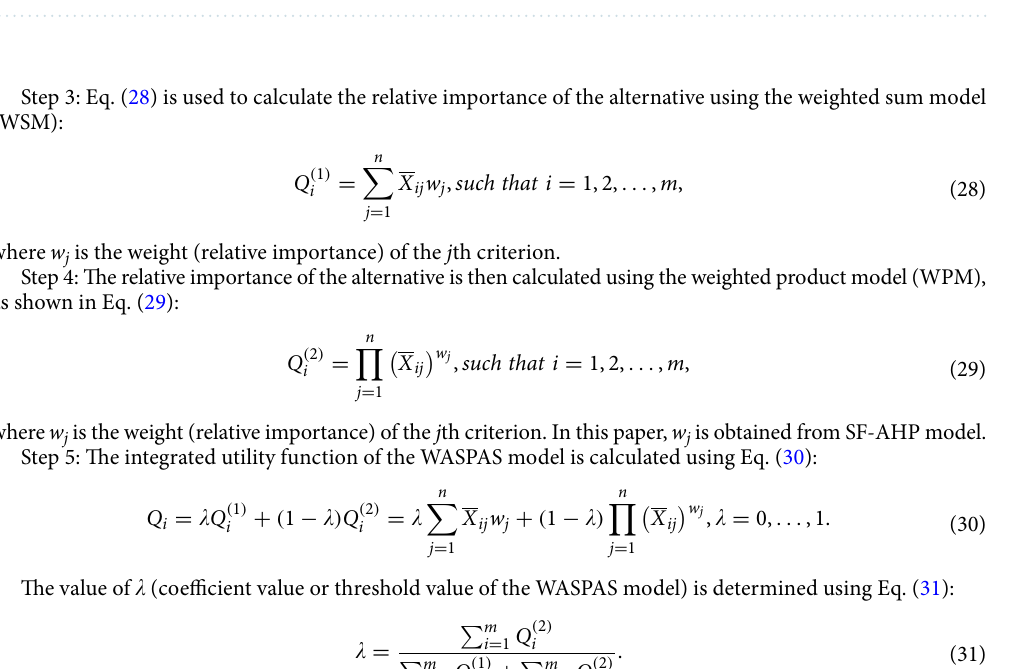
Table 4. List of potential offshore wind locations in